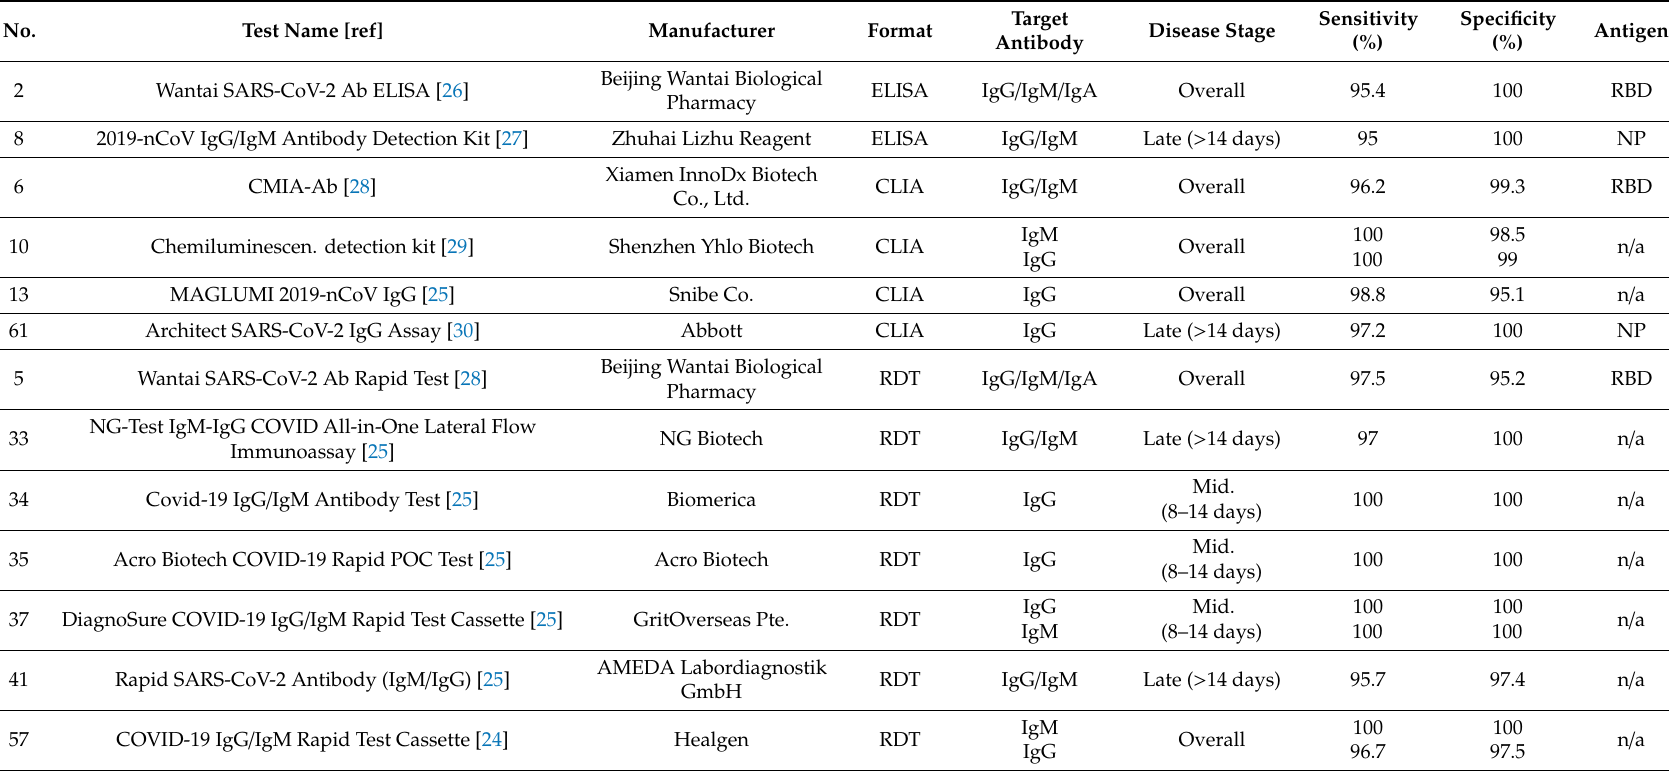
Table 1. Top-performing COVID-19 serological tests based on independent evaluations of sensitivity /